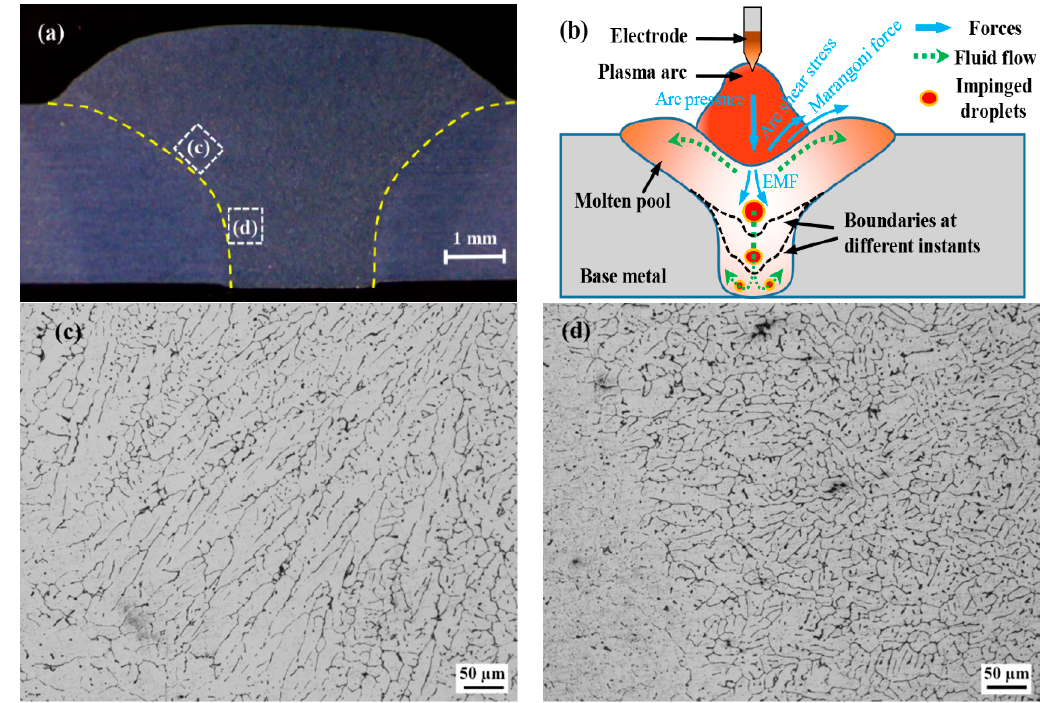
Figure 2. Welding torch perpendicular to the surface of the base metal in the transverse section. ( a ) Molten pool profile; ( b ) schematic diagram of the molten pool behavior; ( c ) columnar grain at the shallow level; ( d ) refined grain at the finger-like penetration (FLP) level.